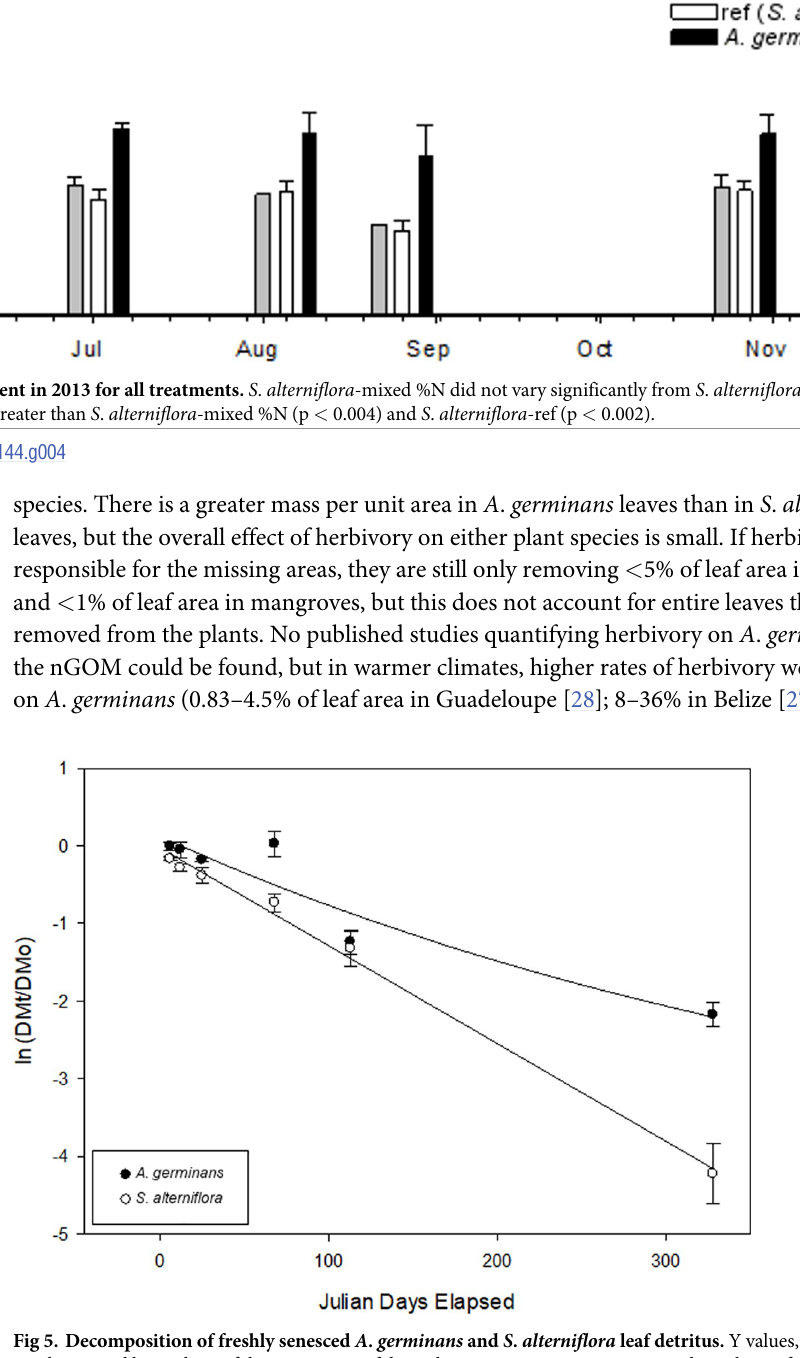
PLOS ONE | https://doi.org/10.1371/journal.pone.0210144 January 7,